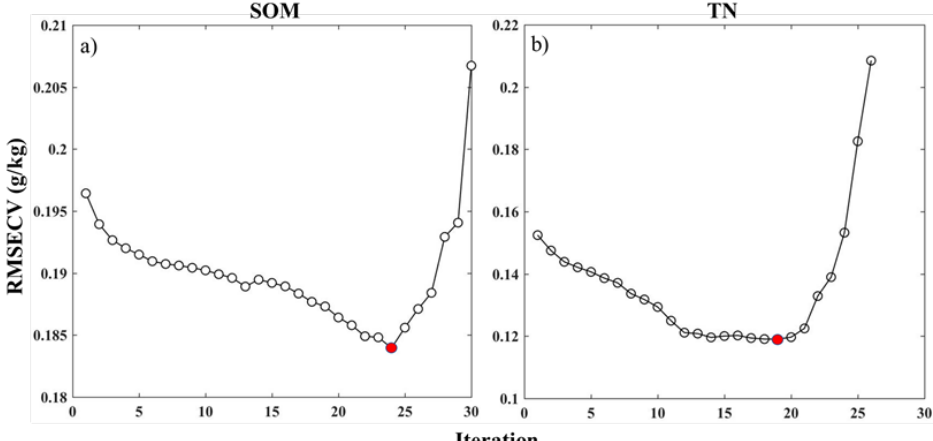
Figure 5. The evolution of RMSECV (g/kg) in sub-models in each iteration of the BOSS algorithm. Note: ( a ) SOM-BOSS; ( b ) TN-BOSS; Red solid circle: point of the minima of the iterations.